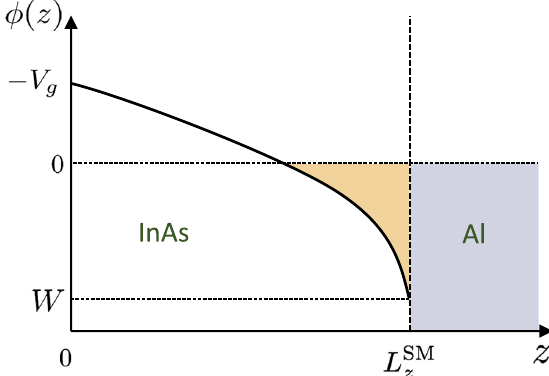
FIG. 2. The electrostatic calculation uses Dirichlet boundary conditions at z ¼ 0 and z ¼ L SM , i.e., the top and bottom of the z semiconducting wire. At z ¼ 0 , the boundary condition is given by the gate voltage V , while at the interface to the aluminum it is g given by the band offset W (see also Table I). This leads to an accumulation layer at the